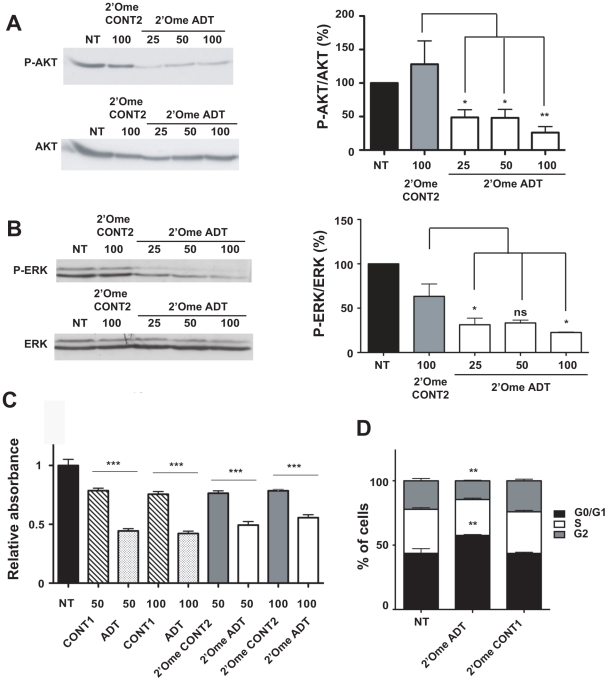
IGF-IR gene silencing inhibits signaling, cell cycle progression and proliferation.EMT6 cells were transfected with 25 to 100 nM 2′-O-methyl ADT siRNA and harvested 48 h later after standard growth conditions (10% FCS) for analysis by immunoblotting with: (A) antibodies against phospho-S473 AKT and total AKT, and (B) antibodies against phospho-T202/T204 ERKs and total ERK. Black bars represent mock transfected cells (NT). Representative experiments are presented and quantitative analysis of three independent experiments are shown on the right of each gel with means ± SEM. * P<0.05; ns, not significant. (C) Proliferation rates of siRNA-transfected EMT6 cells 48 h post-transfection; *** P<0.001, Student's t-test. (D) For cell cycle analysis, EMT6 cells were transfected with 50 nM siRNA and analyzed 48 h later by cytometry and propidium iodide staining. Experiments were performed in triplicate. Statistical analysis was referred to control siRNA treated cells. ** P<0.01.